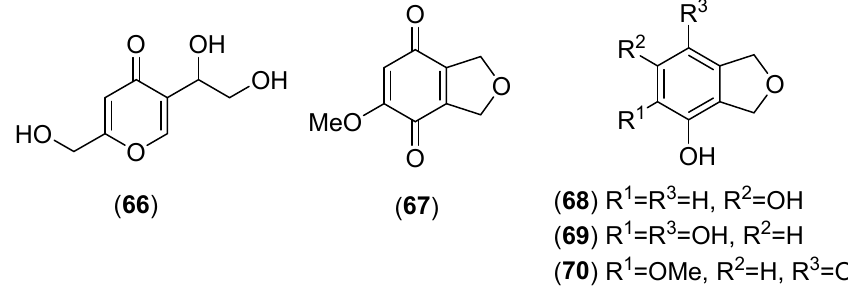
Figure 13. Chemical structures of selected compounds isolated from Neolentinus lepideus.